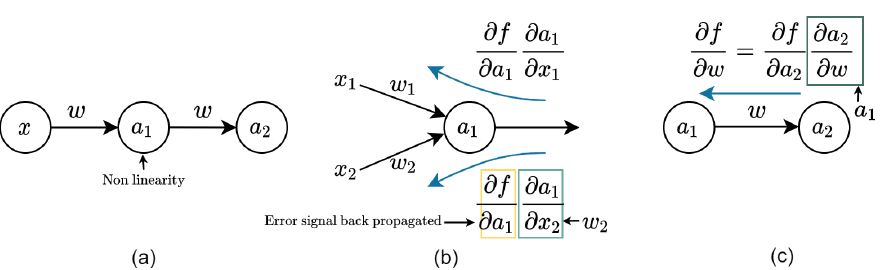
Figure 1. A simple illustration of forward and backward inference in a neural network training. Subfigure ( a ) denotes the forward inference of neural networks, where non-linearity is introduced during the activation stage. Subfigure ( b , c ) represent the error backpropagation of neural networks. As indicated by the equations in ( b , c ), the error signals are backpropagated by computing the gradients of each weight by chain rule.